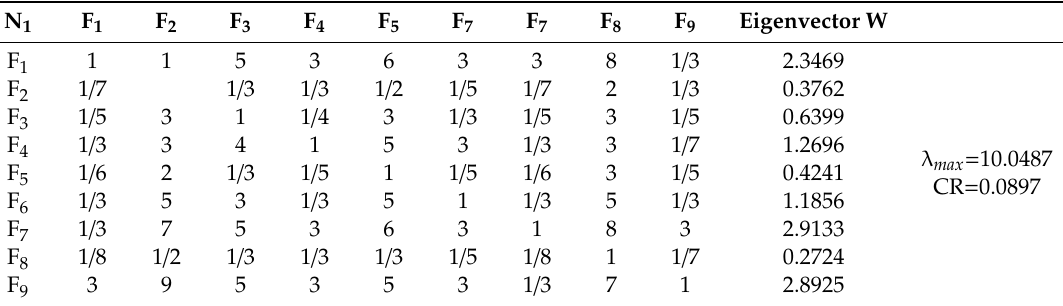
Table 10. F-N 1 judgment matrix.